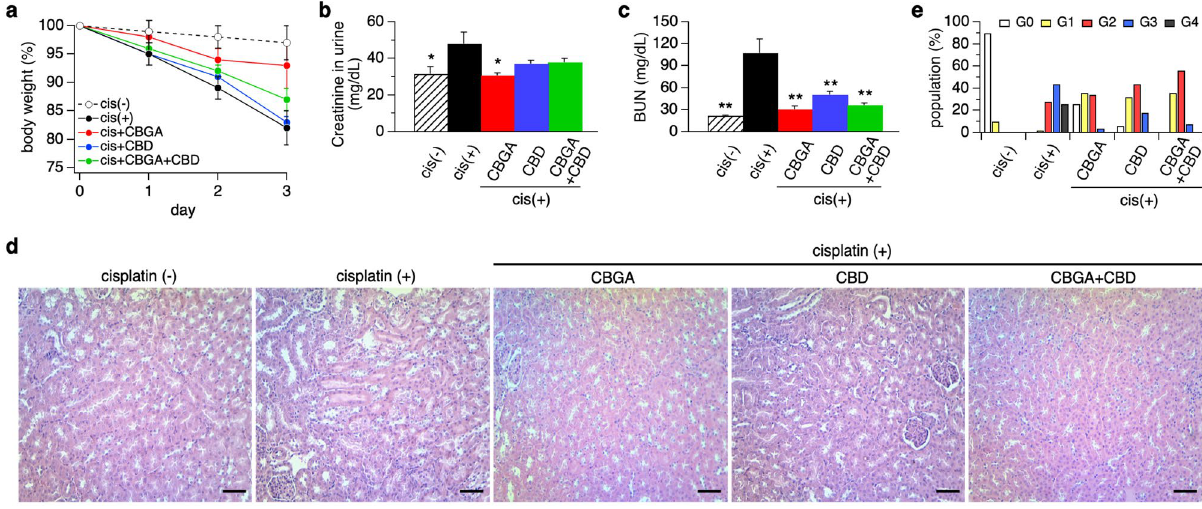
Figure 1. CBGA and CBD prevent kidney functional loss and damage in the cisplatin-induced acute nephropathy mouse model. ( a ) Body weight of mice was measured daily before administration of CBGA (10 mg/kg, red circles), CBD (10 mg/kg, blue circles), CBGA + CBD (each 10 mg/kg, green circles) from day 0 to day 3. The cisplatin (+) group was injected daily with vehicle in cisplatin-administered mice as a control (cis (+), black circles). Cisplatin was injected 2 h after the first cannabinoid administration at day 0. The animal group without cisplatin administration received vehicle instead of cisplatin as a negative control against cisplatin- induced nephropathy (cis (−), n = 4, white circles). Body weight of each day was normalized by the weight before cannabinoid injection at day 0 and the average is indicated (n = 5). ( b ) Creatinine levels were determined